Question: Judging by this figure, is the value going up or going down?
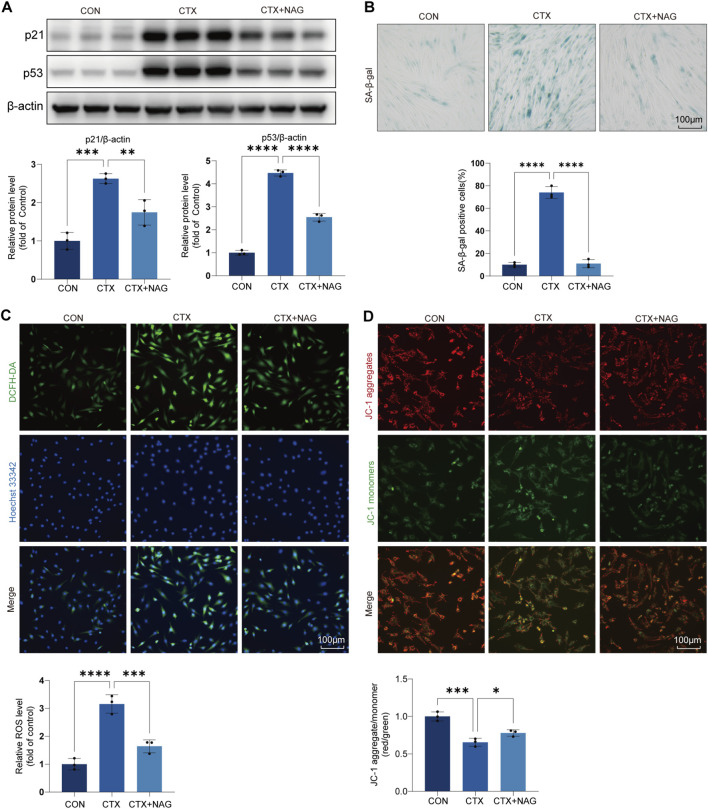
Answer: decreasing